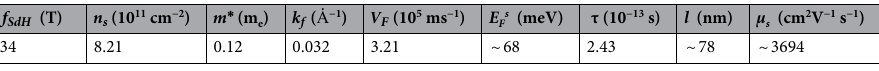
Table 1. Parameters extracted from the SdH